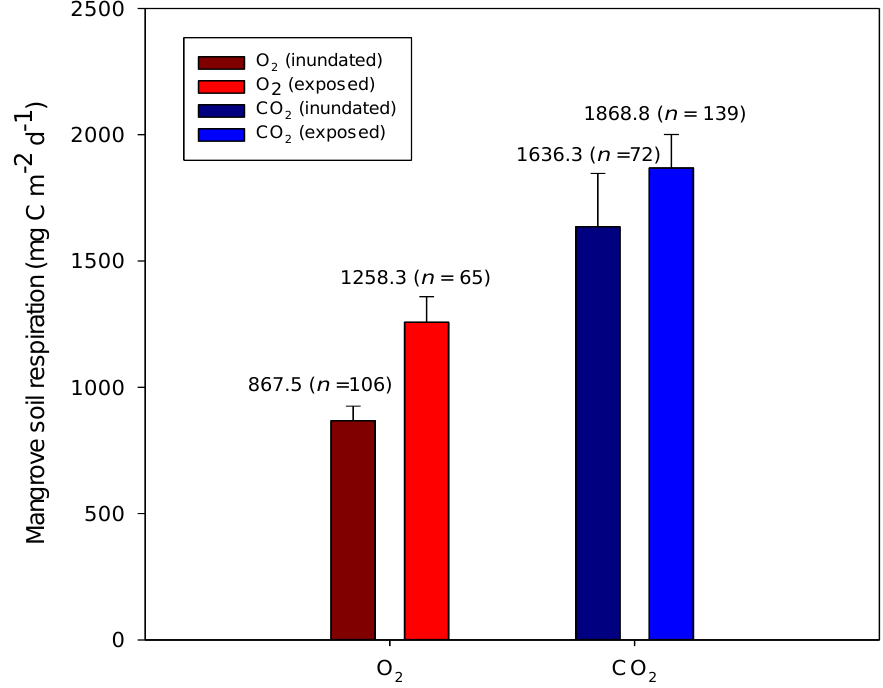
Figure 1. Mean ( ± 1 standard error) rates of dissolved and gaseous oxygen consumption and dissolved inorganic carbon (DIC) production and CO 2 release (mg C m − 2 d − 1 ) from tidally inundated and exposed mangrove soils, respectively. Field measurement and soil incubation data from references [17–54] were obtained from searches of the Web of Science and Google Scholar.